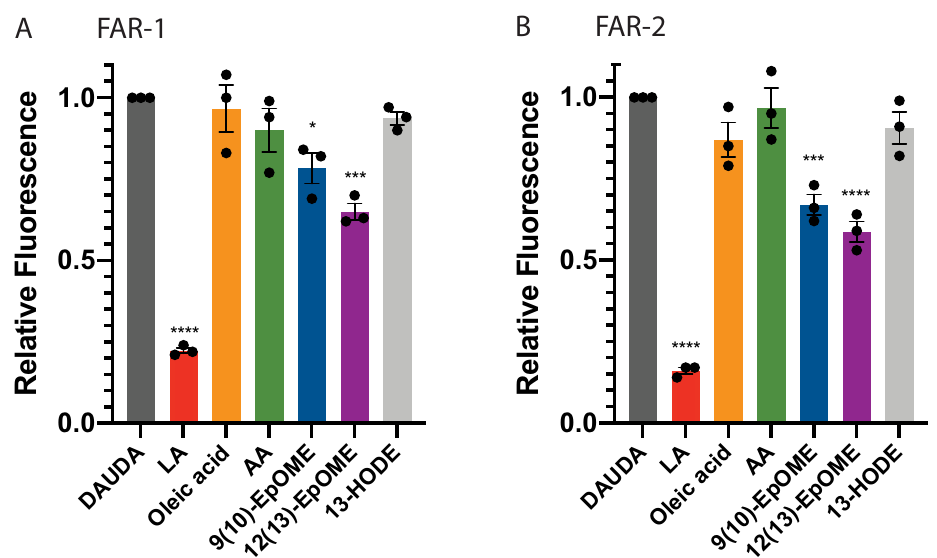
Fig 5. In vitro binding of Sc-FARs. A&B) Competitive binding between 10-fold excess linoleic (LA), oleic, arachidonic (AA) acid, and other fatty acids (all 10 μ M) and DAUDA (1 μ M) was tested in the context of FAR-1 & 2. Linoleic acid displaces DAUDA the most, as seen by the largest reduction in relative fluorescence. Both 9(10)- and 12(13)-EpOME displace DAUDA more easily in the presence of FAR-2, showing tighter binding. Statistics shown as One-way ANOVA and error bars show mean+SEM. All raw data available in supplemental